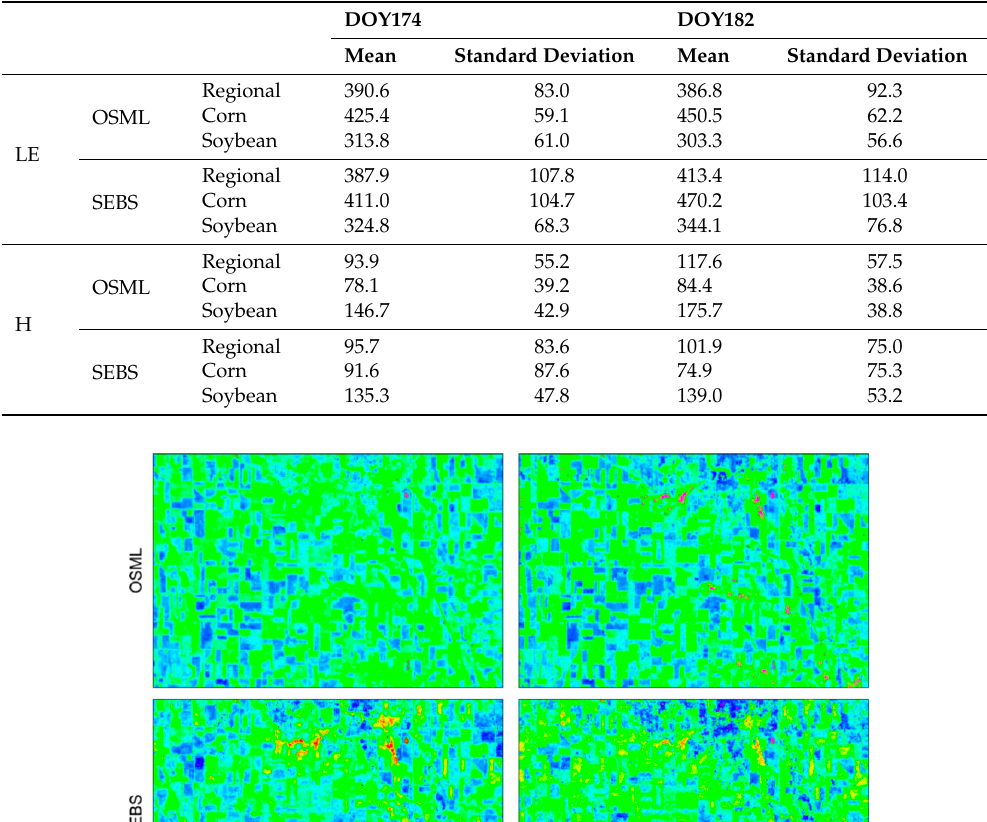
Table 3. Statistics for regional-scale land surface heat fluxes estimation (W/m 2 ).